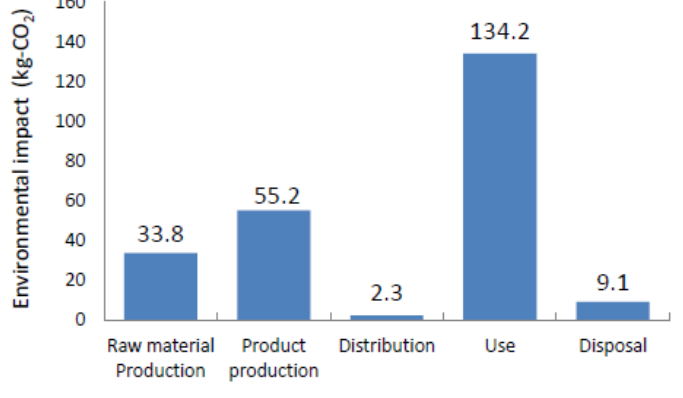
(LCCO ) data for toilet 2 2